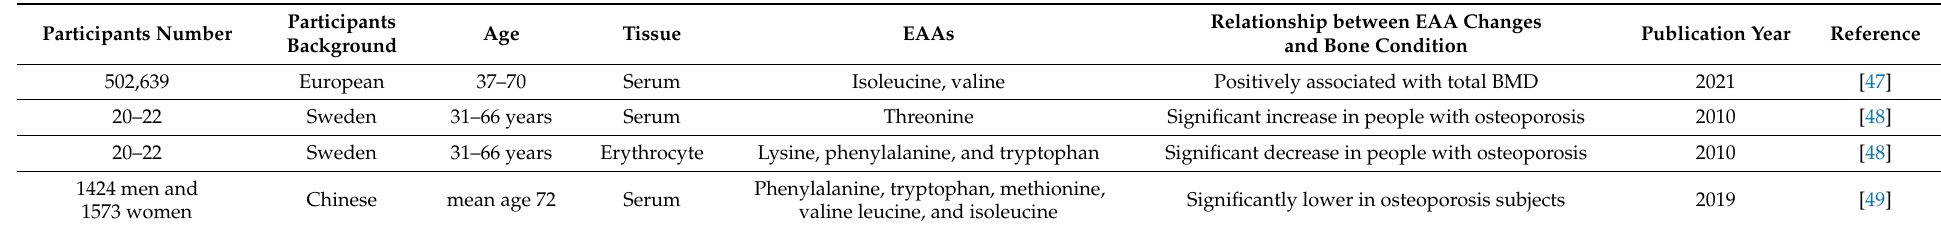
Table 1. EAA content in aging people with